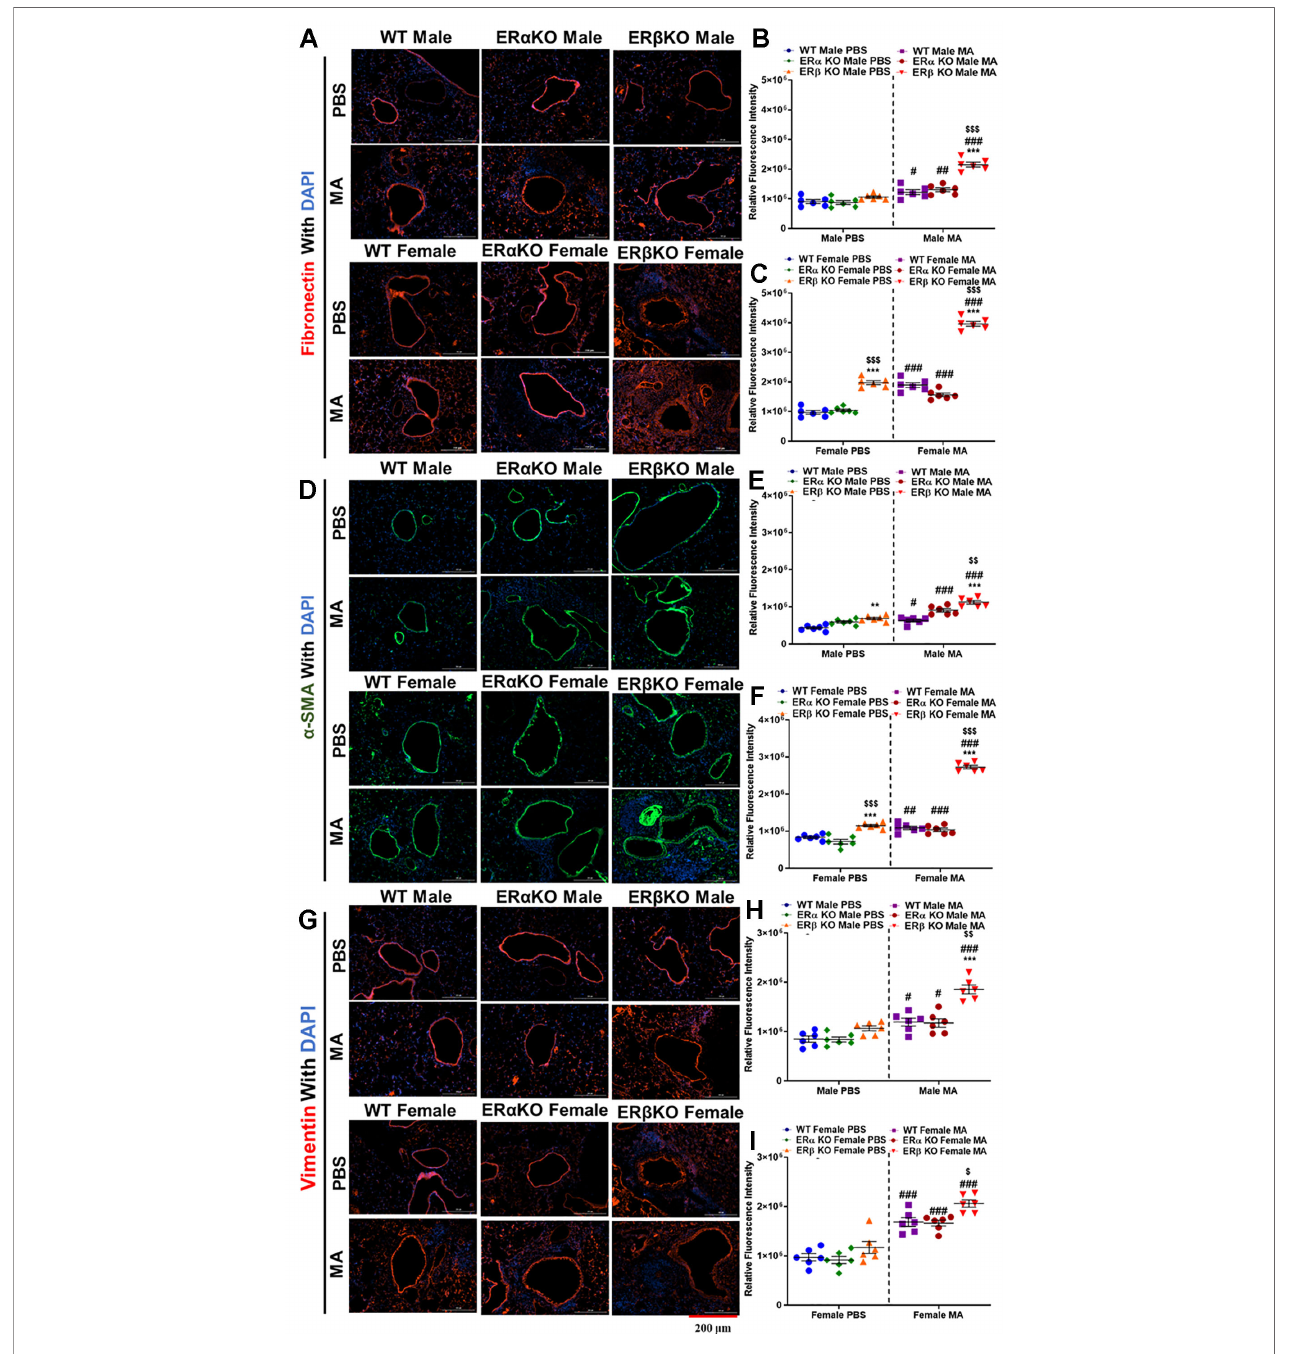
FIGURE 9 | Effect of ER signaling on expression of fi bronectin, a -SMA and vimentin. Representative images of airway sections probed with fi bronectin (A) , quanti fi cation of relative fl uorescence intensity (RFI) of fi bronectin in males (B) and females (C) . Representative images of airway sections probed with a -smooth muscle actin ( a -SMA, D ), quanti fi cation of RFI of a -SMA in males (E) and females (F) . Representative images of airway sections probed with vimentin (G) , quanti fi cation of RFI of vimentin in males (H) and females (I) . Data in b, c, e, f, h and i represented as mean ± SEM of at least 6 mice per treatment group. # p < 0.05, ## p < 0.01, ### p < 0.001 vs. PBS of respective groups (MA effect) and **p< 0.01, ***p< 0.001 vs. WTofPBS/MA(ER speci fi c KOeffect) $ p < 0.05, $$ p < 0.01, $$$ p < 0.001, vs. ERa KOof PBS/MA (ERb vs. ERa